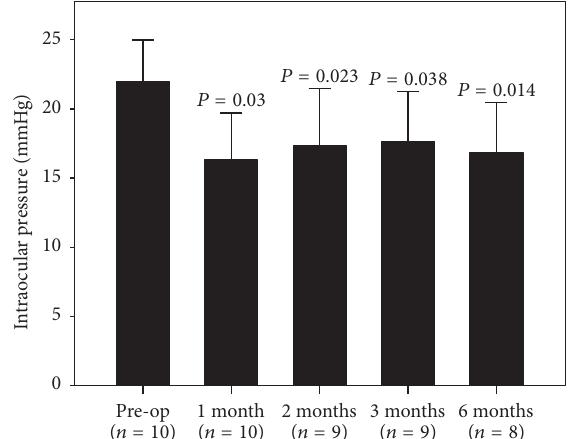
Figure 1: Mean intraocular pressure (+ standard deviation) at each study visit. The observed decrease in the mean intraocular pressure for all of the postoperative visits was statistically significant from the preoperative intraocular pressure values ( 𝑃 < 0.05 , Dunnett’s procedure versus pre-op).